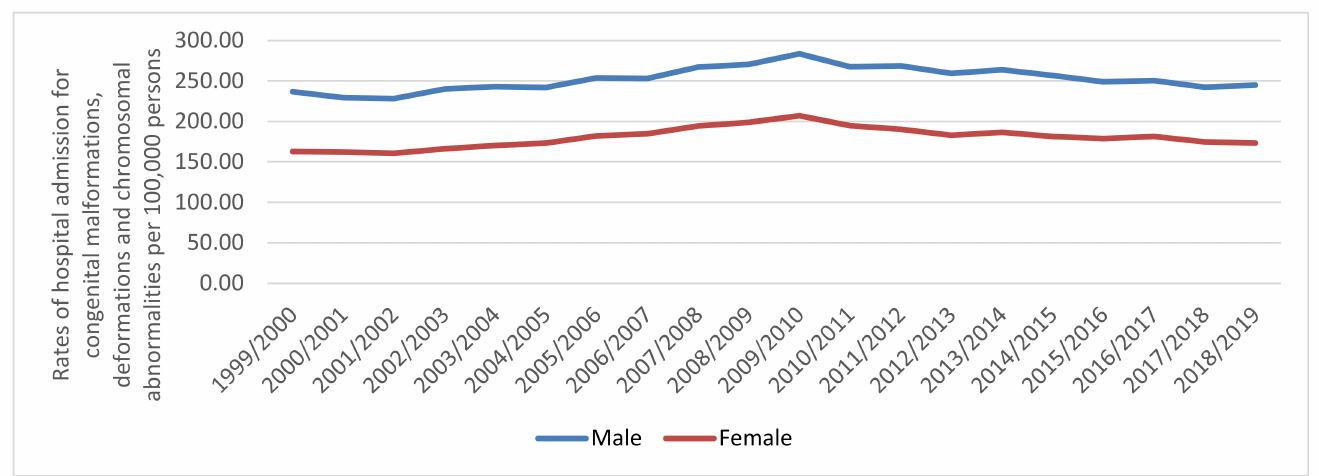
Figure 3. Rates of hospital admission for congenital malformations, deformations and chromosomal abnormalities in England and Wales stratified by sex.